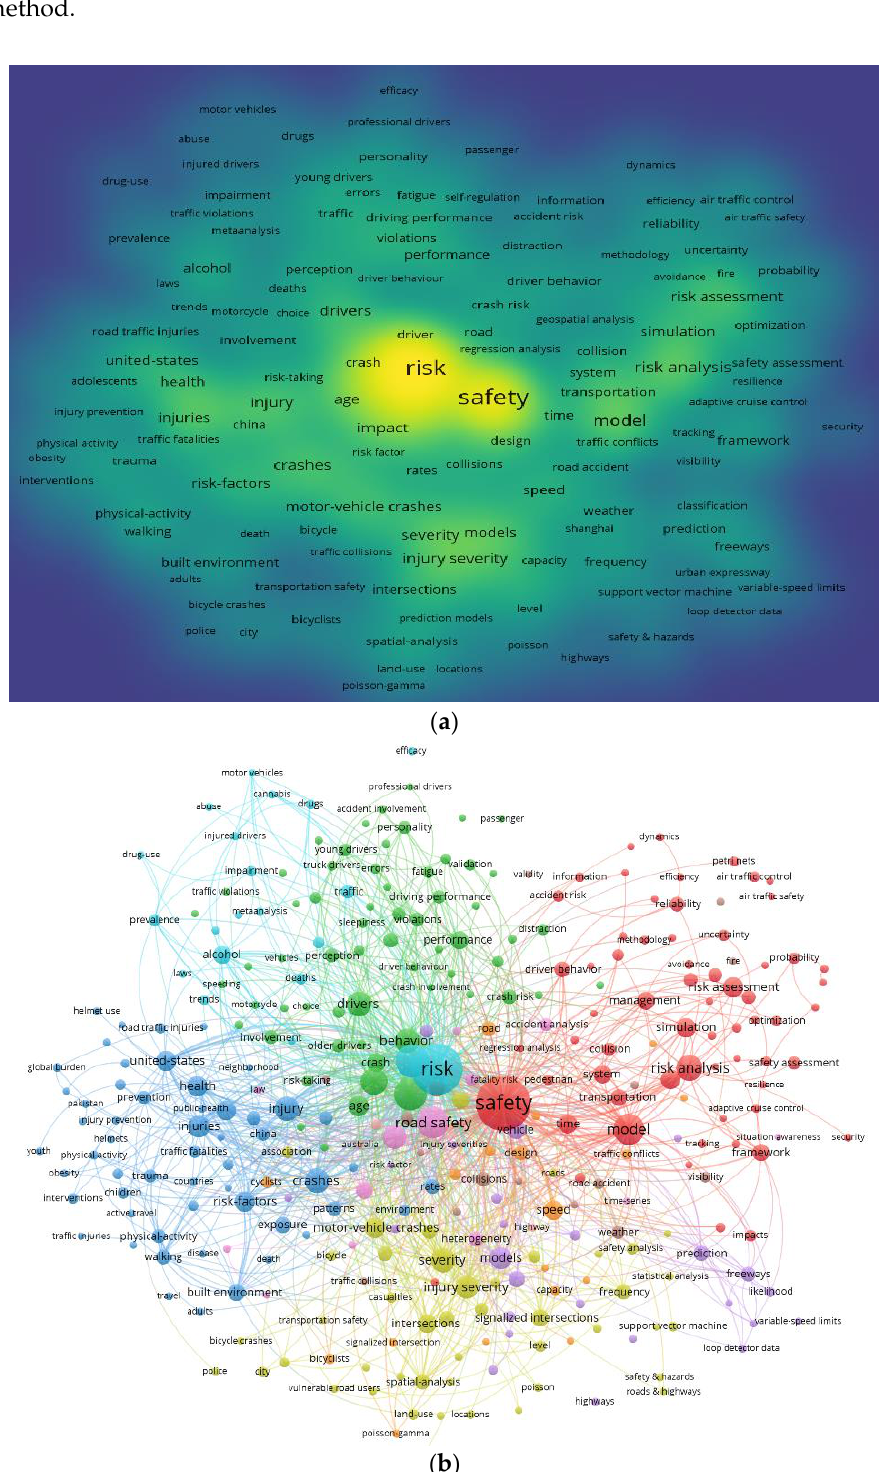
Figure 1. The keywords in risk assessment studies, 1997–2019. ( a ) The density of main research keywords; ( b ) the keywords co-occurrence network of risk analysis studies. keywords; ( b ) the keywords co-occurrence network of risk analysis